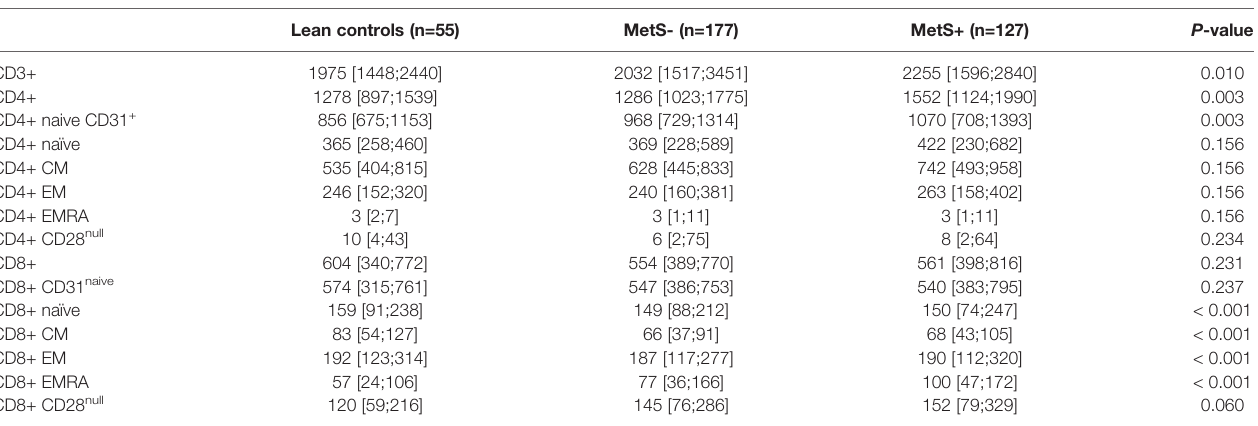
TABLE 2A | Absolute numbers of the T cell